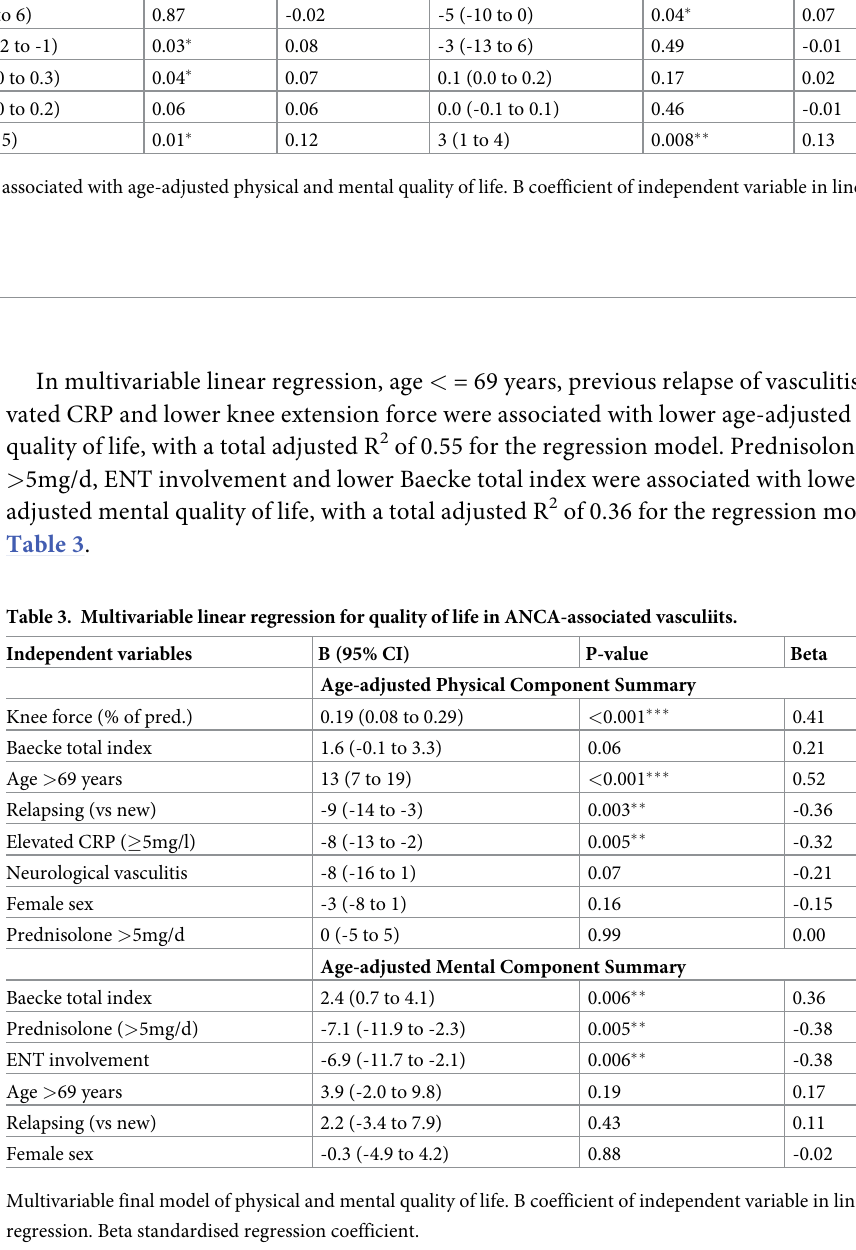
Multivariable final model of physical and mental quality of life. B coefficient of independent variable in linear regression. Beta standardised regression coefficient.